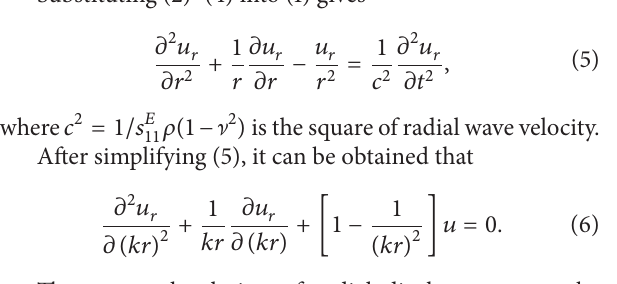
Figure 1: Model of single circular